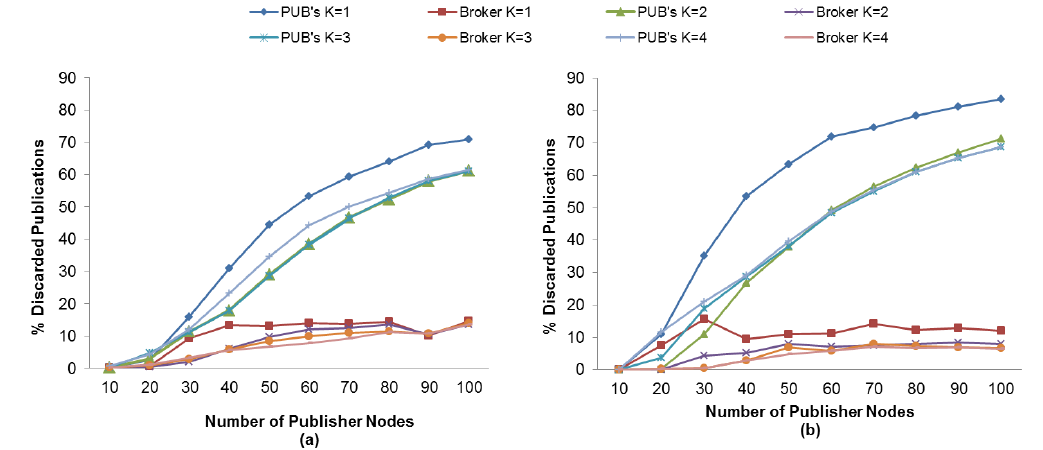
Figure 10. Effect of the number of Publisher nodes on the Discarded Publication Ratio from Broker and Publisher Nodes using different K values without ( a ) and with ( b ) MAC